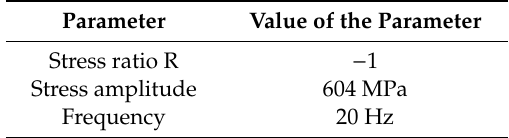
Table 4. Parameters used in high cycle fatigue (HCF) test.